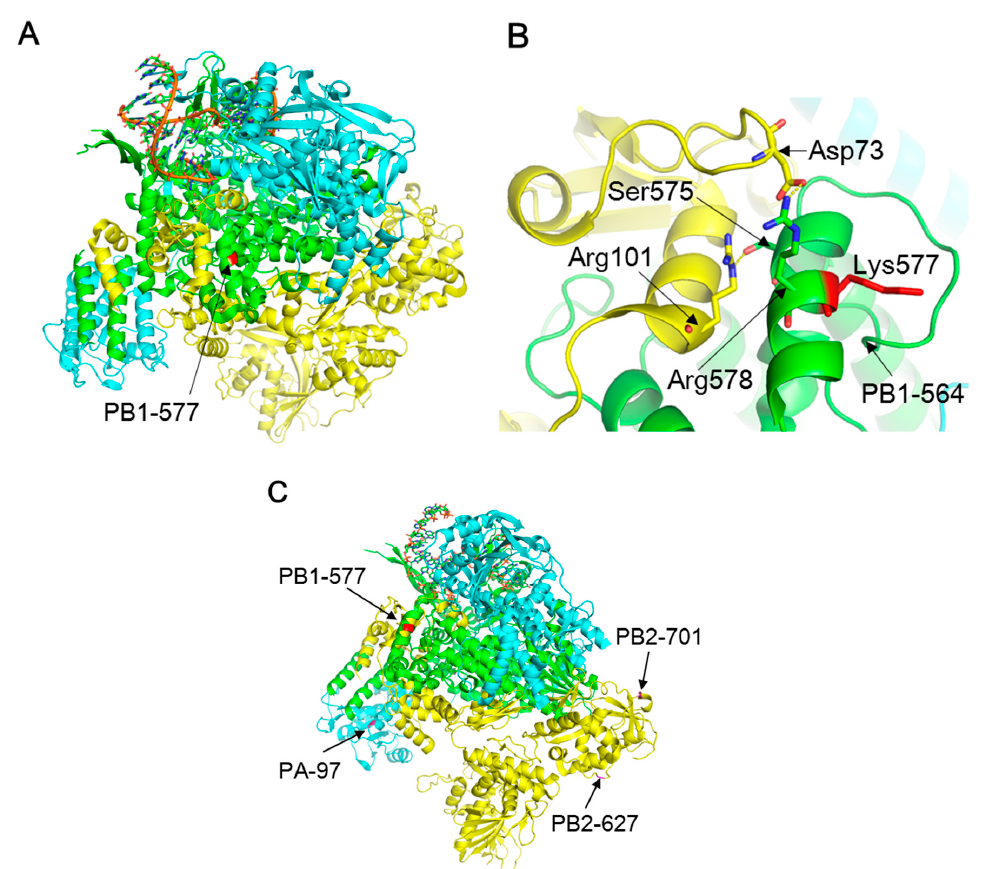
Figure 5. 3D structure of the viral polymerase complex (PDB: 4WSB). The PB2, PB1, and PA subunits are shown in yellow, green, and cyan, respectively. ( A ) The amino acids at position 577 in PB1 (PB1-577) are colored in red; ( B ) Close-up view of the vicinity of PB1-577. Polar contacts are made between PB2-Arg101 and PB1-Ser575, and between PB2-Asp73 and PB1-Arg578; ( C ) Amino acid positions PB1-577, PA-97, PB2-627, and PB2-701 are indicated.